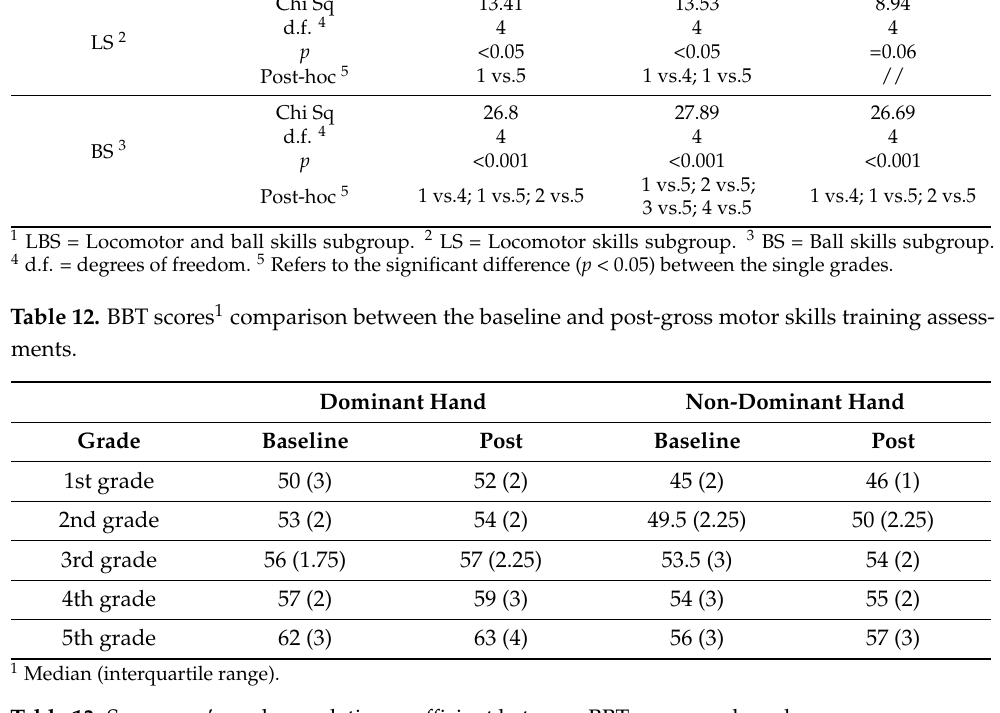
Table 13. Spearman’s rank correlation coefficient between BBT scores and grades.